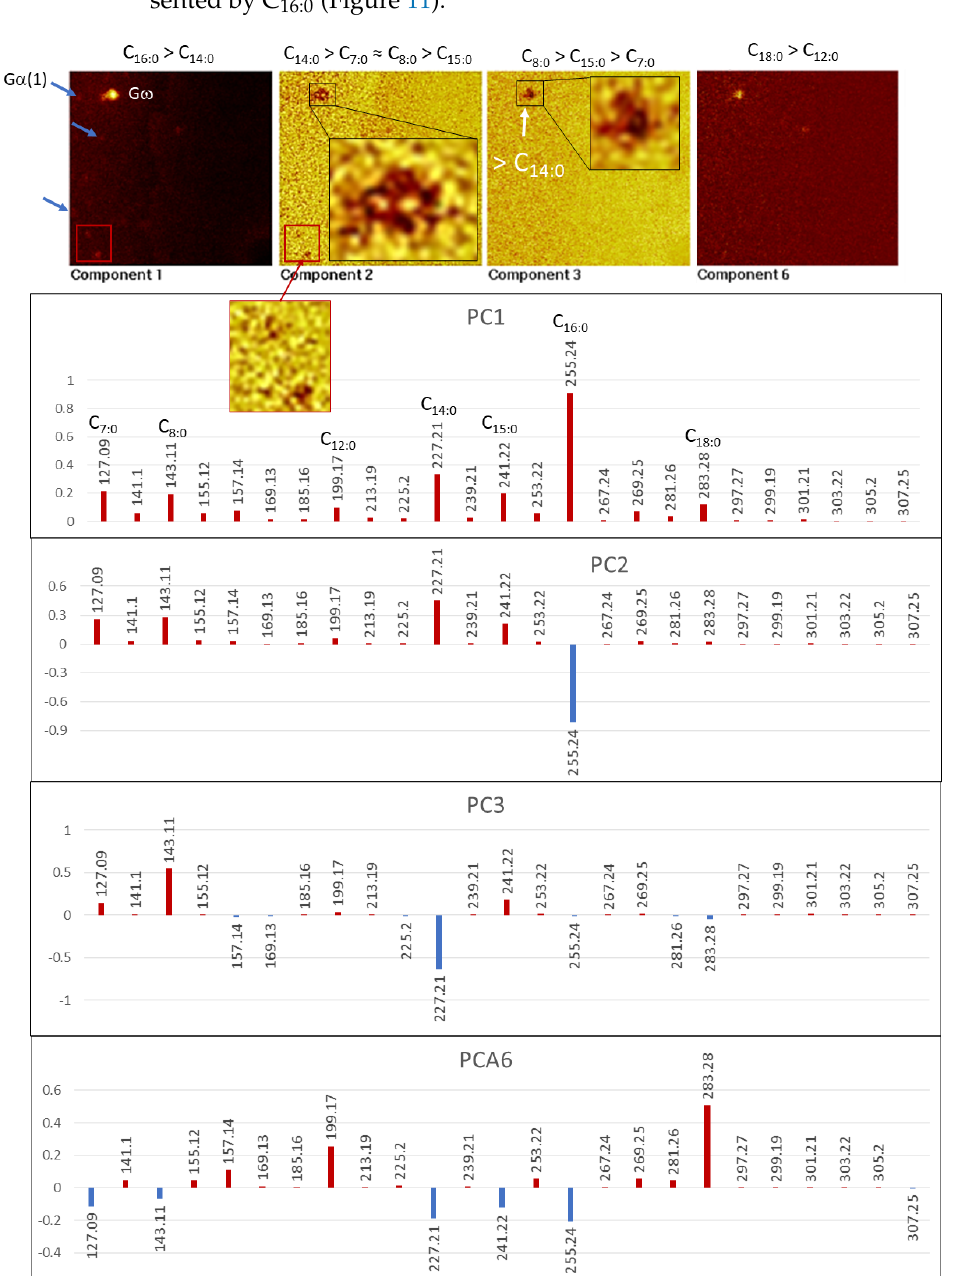
Figure 11. Principal component analysis (PCA) obtained through the ToF-SIMS FA data obtained in TA2. For such analysis, 25 masses identified as FA adducts were considered. As in TA1, the analysis shows (see PC1) that the primary FA in the sample is C 16:0, followed by C 14:0 , which are mainly found in G ω , and G α (1). They are respectively associated with acylglyceride fragments and NO − n(2 ≤ n ≤ 3) ions (blue arrows). Furthermore, such a distribution also suggests that C 14:0 is the most abundant FA outside the G ω , and G α (1) microstructures. PC2, PC3, and PC6 reveal a heterogeneous FA distribution inside the G ω microstructure suggesting a diverse internal composition. The red square points a couple of micronodules showing an internal variation as observed in the G ω microstructure. The ToF-SIMS images were obtained from a rasterized surface area of a 500 µ m square.